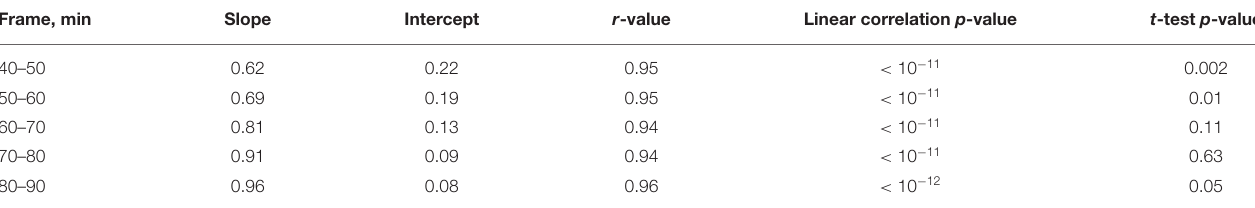
TABLE 1 | Fit parameters for the investigated frames and their corresponding p -values from pairwise t -tests with the quantification method as a within-factor (last column). Frame, min Slope Intercept r -value Linear correlation p -value t -test p -value 0.95 < 10 − 11 0.002